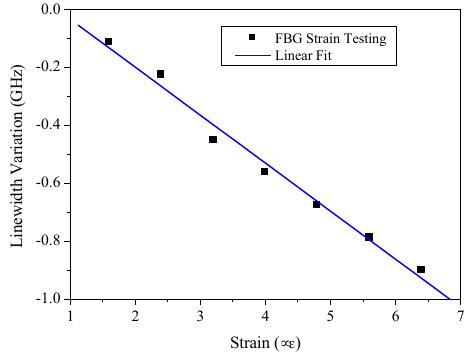
Figure 4. The fiber strain sensitivity from two FBG reflective spectrum correlation.